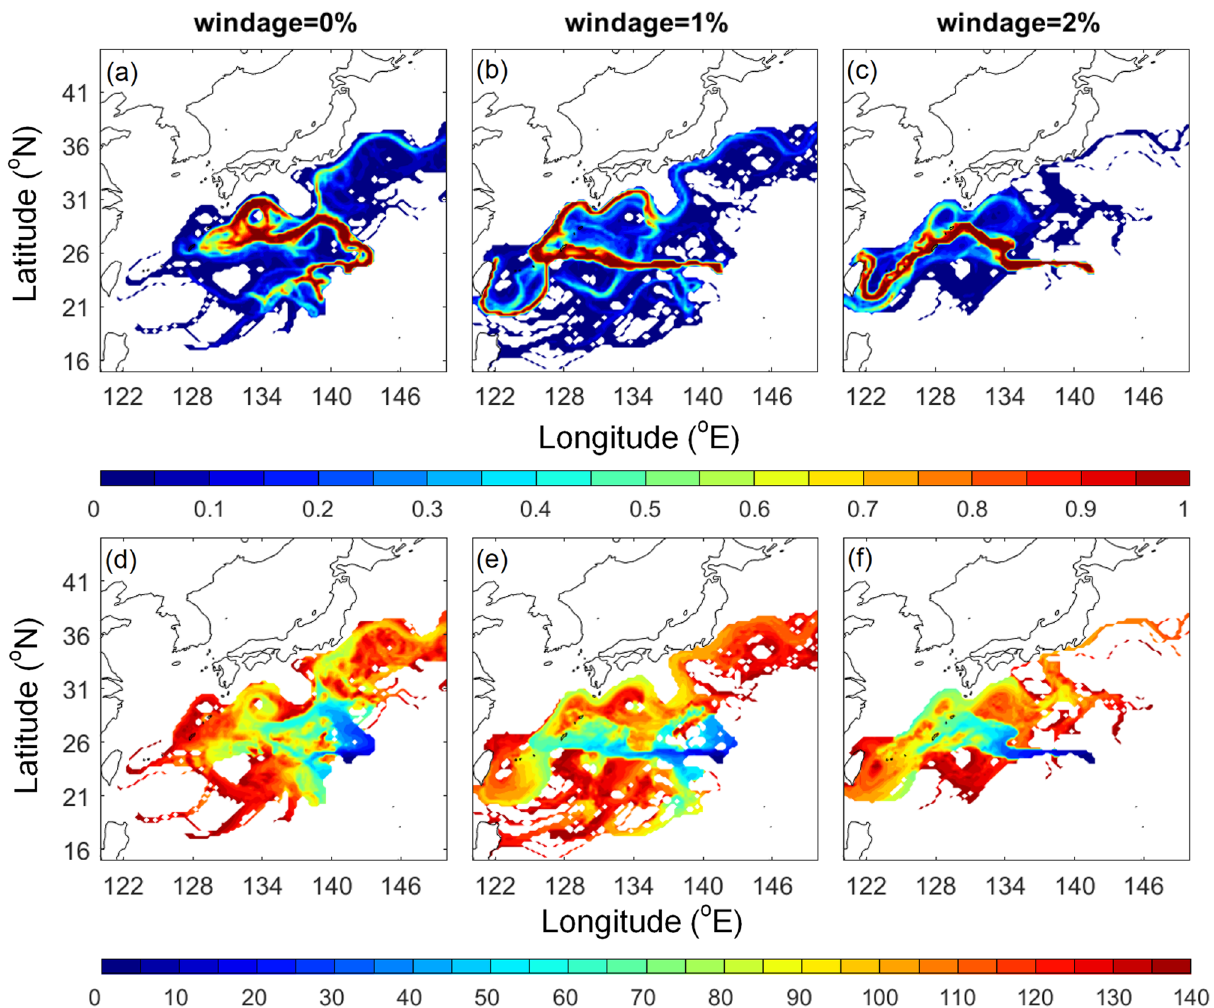
Figure 9. ( a–c ) Normalized visitation frequency and ( d – f ) time-evolving distribution (days) based on 2021 daily hindcast ocean currents with windage of (a, d) 0%, (b, e) 1%, and (c, f) 2%. Figure is created using MATLAB R2011b (http:// www. mathw orks.